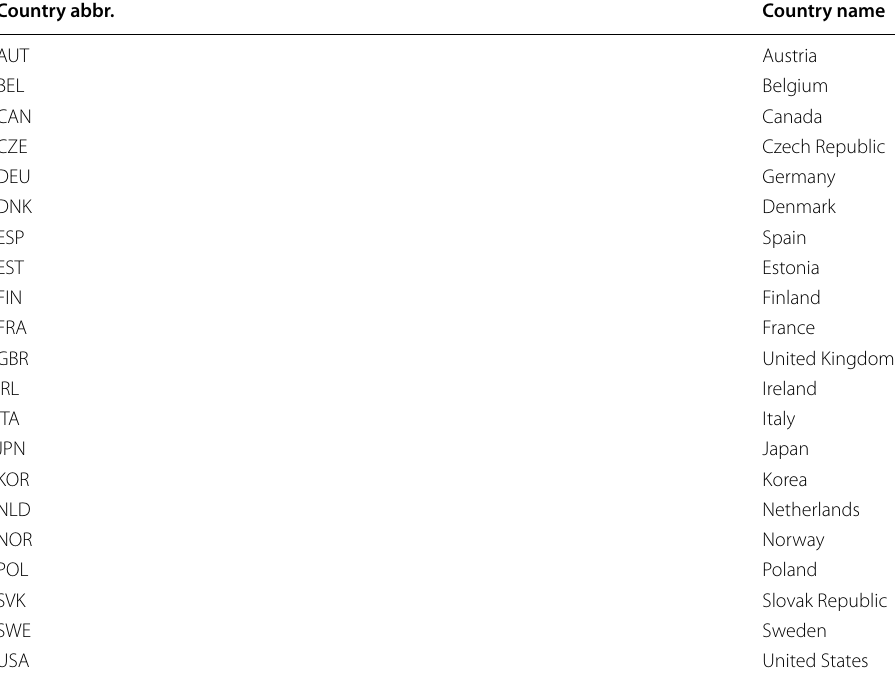
Table 4 Country names and abbreviations Country abbr.